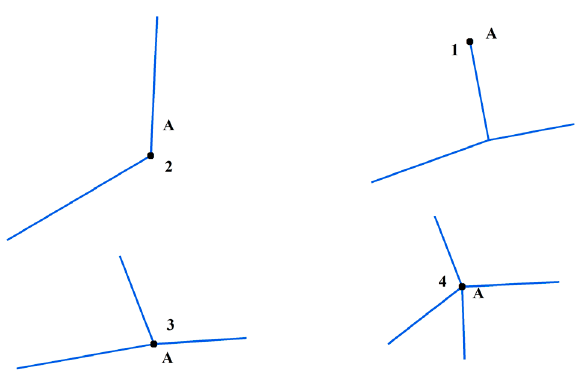
Fig. 5. Degree of nodes